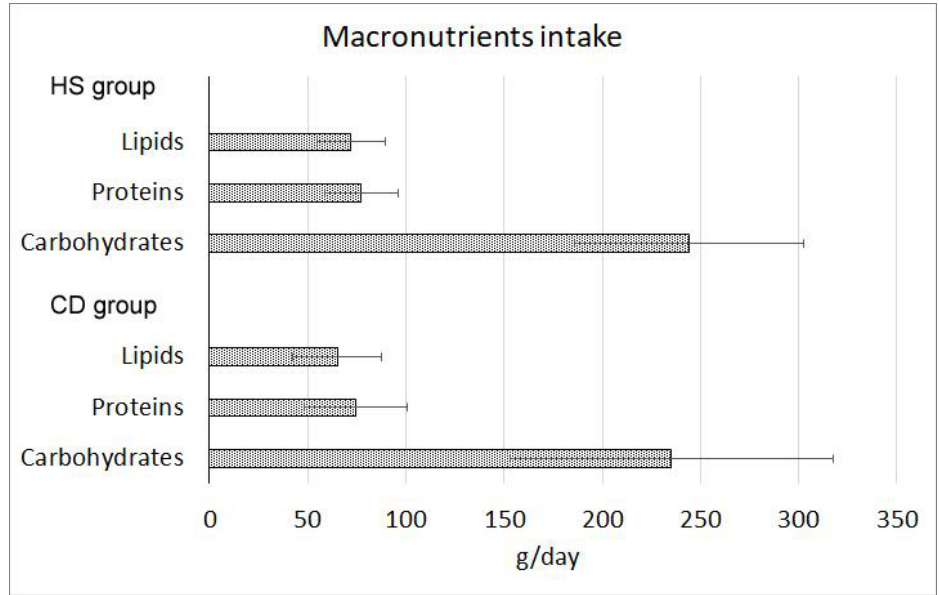
Figure 1. Macronutrient consumption indicated in grams per day (±standard deviation) in healthy subjects (HS) and Crohn’s disease (CD) patients groups. All the differences were not statistically significant ( p > 0.05).